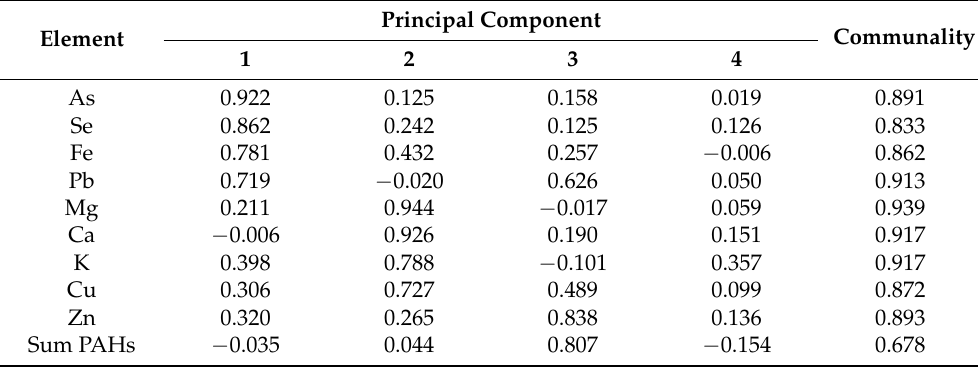
Table 2. Principal component data matrix (rotated) for potentially toxic elements and polycyclic aromatic hydrocarbons (PAHs) in